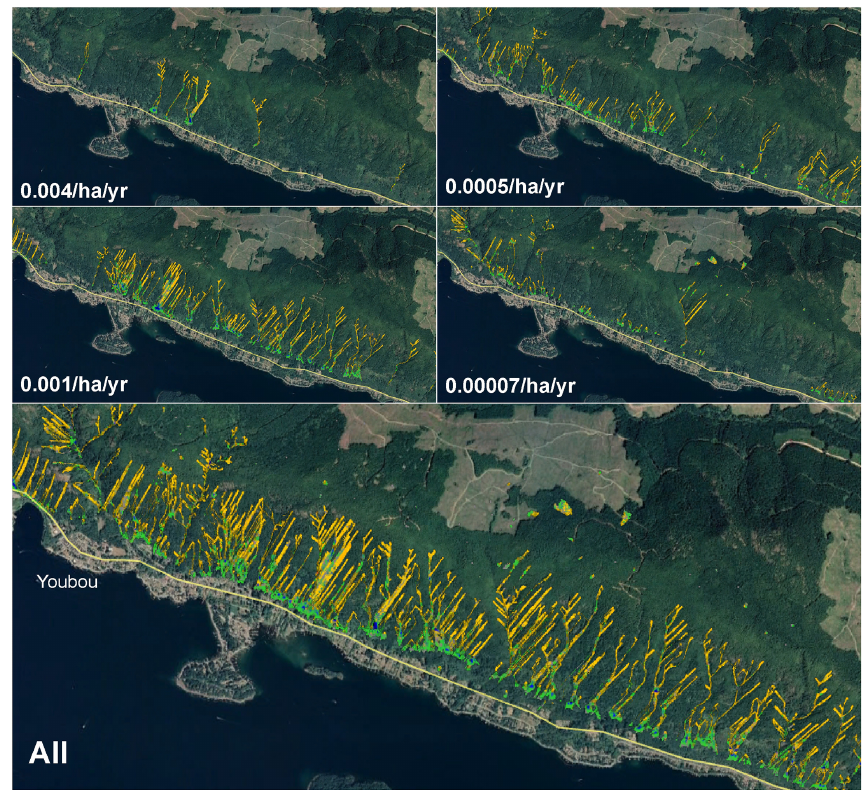
Figure 19. Modeled landslides along the north shore of Cowichan Lake from different hazard zones and overall. Results can be imported into Google Earth, as shown here, for convenient visualization (background image © Google Earth).